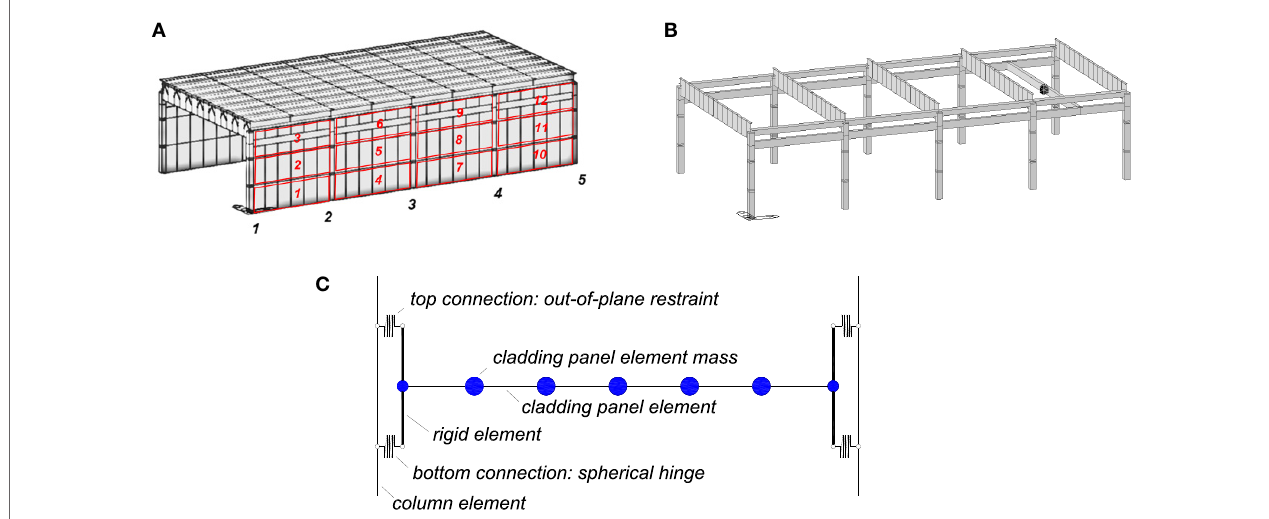
FigUre 11 | Considered case study: (a) complete model; (B) model without visualizing the roof beams and the cladding panels; and (c) model scheme of the cladding